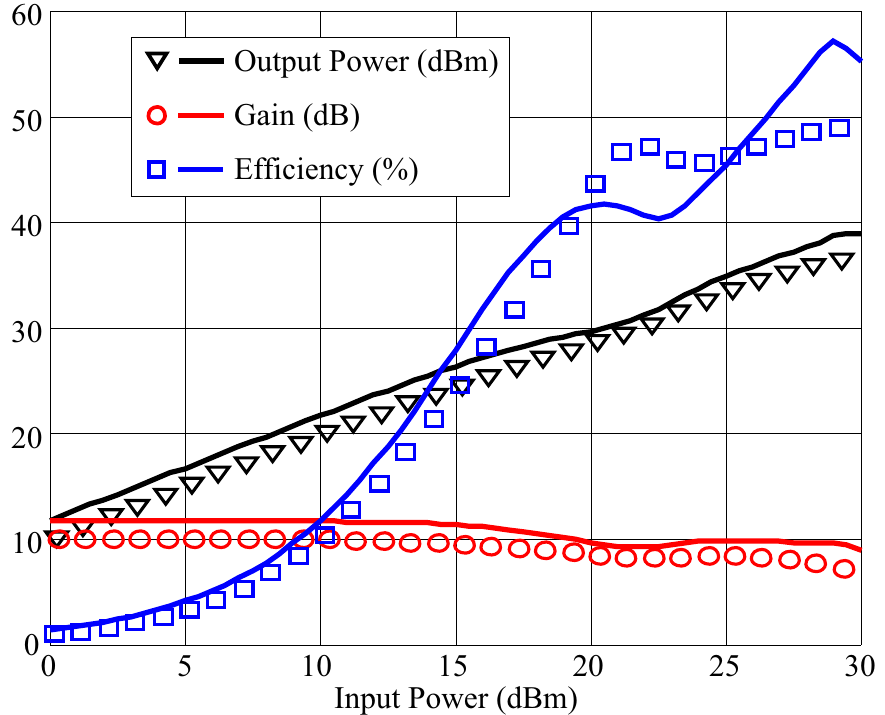
Figure 7. Commercial foundry Doherty PA C.W. characterization at 7 GHz: output power, gain and efficiency vs. input power. Simulations (solid lines) and measurements